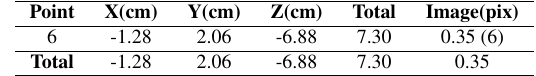
Table 5. CPs RMSE - Flight 2 - 28/12/2019 1:25PM